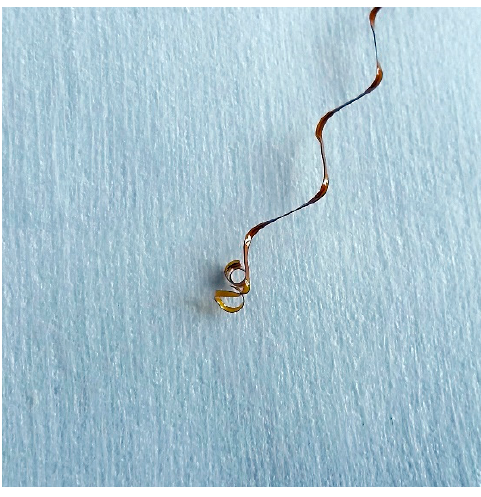
Figure 8. Delamination of the coverlay and curling of the FCB materials after tensile tests performed on the interconnects. Table 4. Average stretchability and planar stretchability (PS) of the tested